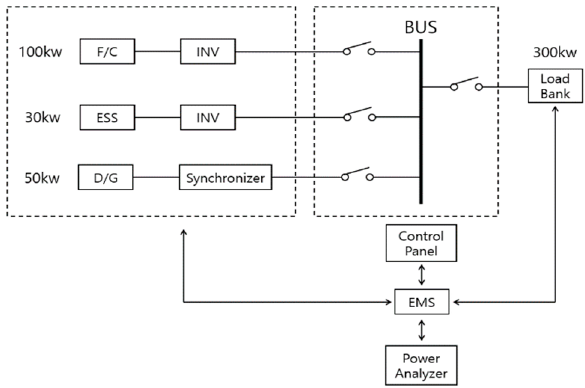
Figure 9. Overall system configuration for power quality analysis.